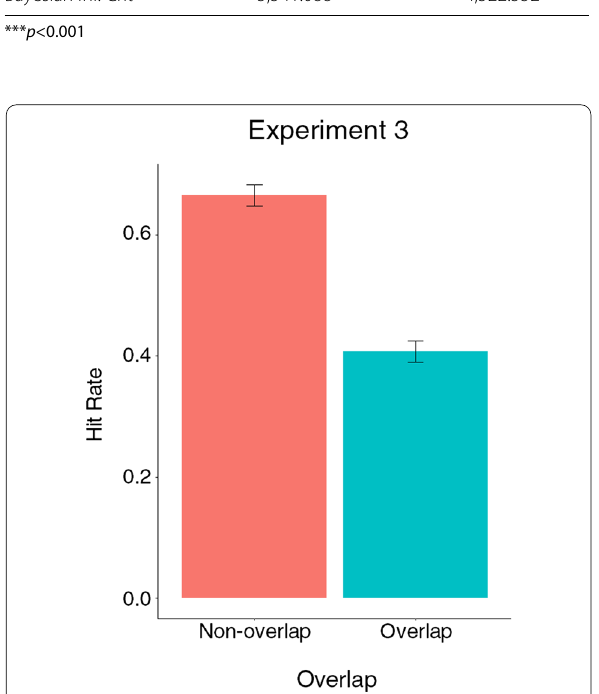
Fig. 9 Hit rate and false alarm rate by overlap corresponding to LMM analysis for Experiment 3 (error bars show 95%